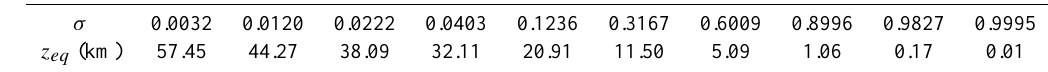
Table 1. Sigma-levels used in the discretization of atmospheric